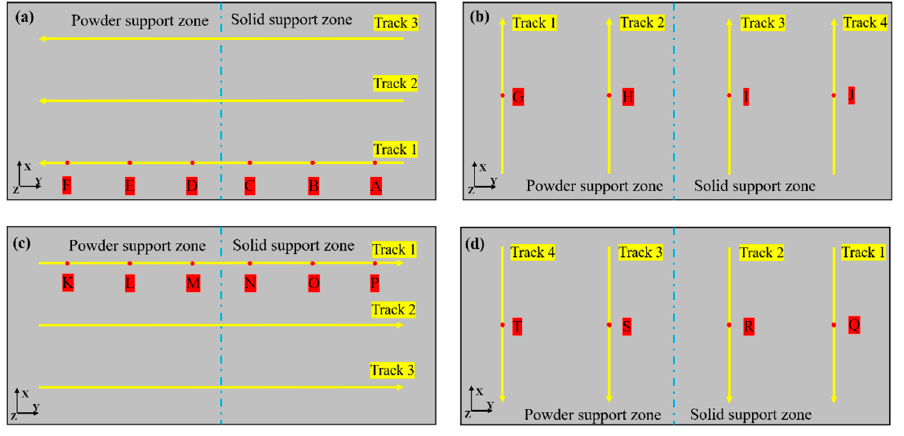
Figure 7. Studied points on different overhang layers: ( a ) Layer 1; ( b ) Layer 2; ( c ) Layer 3; and ( d ) Layer 4.